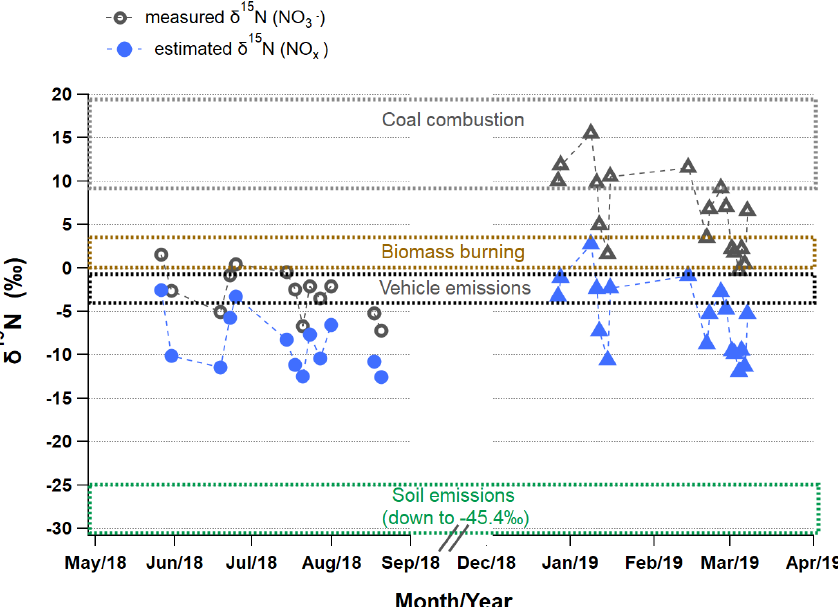
− ) (open) and estimated δ 15 N (NO x ) atmosphere (closed) in Seoul during the summer (circle) Figure 5. Variations in measured δ 15 N (NO 3 and winter (triangle). The δ 15 N (NO x ) range (mean ± 1SD) of source endmembers is distinguished by dotted boxes in different colors: coal combustion (14.2‰ ± 4 . 5‰; Felix et al., 2012; Heaton, 1990), biomass burning (1.8‰ ± 1.8‰; Fibiger and Hastings, 2016), vehicle emissions ( − 2 . 5‰ ± 1.5‰; Walters et al., 2015), and biogenic soil emissions ( − 35 . 1‰ ± 10.2‰; Felix and Elliott, 2014; Li and Wang, 2008; Yu and Elliott,